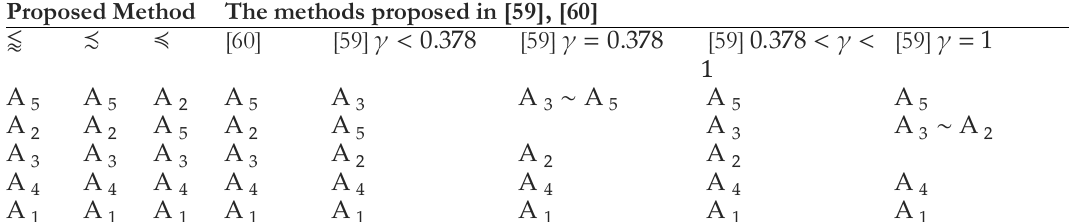
Table 9. Ranking obtained for the alternatives considering several total orders and the obtained in